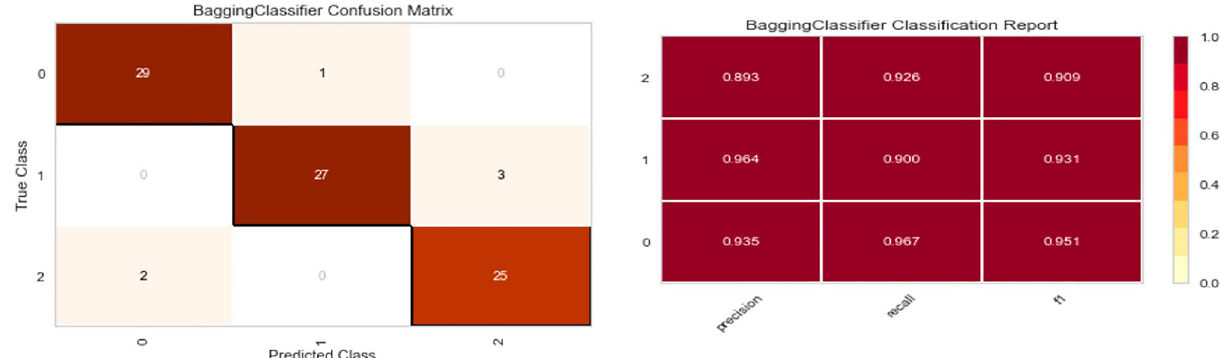
Figure 10. Matrix confusion and Report Classification of Bagging Classifier.